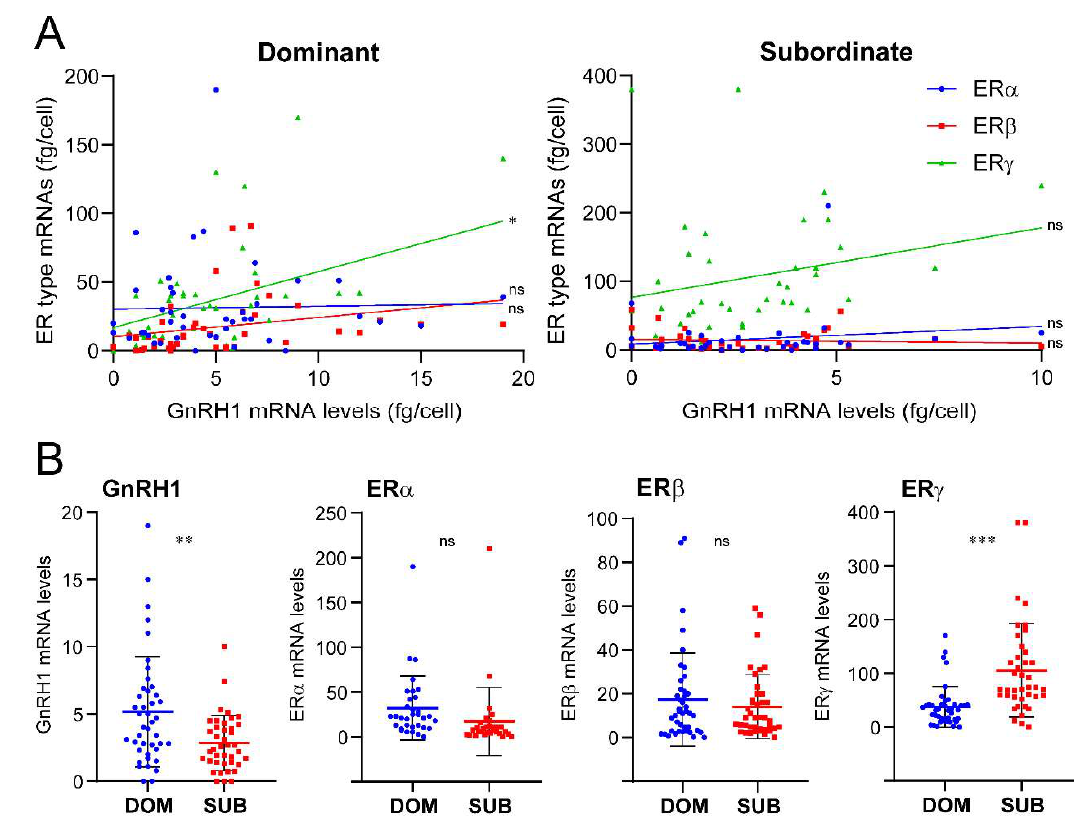
Figure 4. Expression of ER genes in GnRH1 neurons in dominant and subordinate male tilapia. ( A ) Graphs showing the expression of ERα (blue dots), ERβ (red dots), and ERγ (green dots) mRNA levels in individual cells in dominant and subordinate males. The X- and Y-axes represent the absolute mRNA levels (fg/cell) of GnRH1 and ER types in individual GnRH1 cells, respectively. ( B ) Scatter blot graphs showing mRNA levels of GnRH1 and ERα-γ in individual GnRH1 cells in dominant (DOM, blue dots) and subordinate (SUB, red dost) males. Correlation of GnRH1 and ER types mRNA levels were examined by Pearson’s r, while the mean difference of GnRH1 and ER types mRNA levels between DOM and SUB were analyzed by an unpaired t test. p values: ** p < 0.01, *** p < 0.001; ns, nonsignificant.